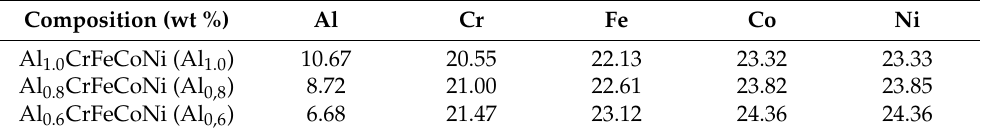
Table 1. Composition (wt %) for analyzed